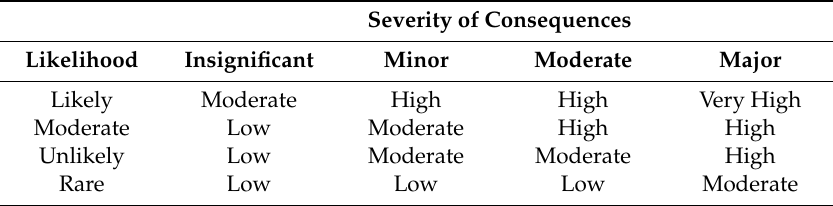
Table 3. Risk-level estimation from likelihood and severity